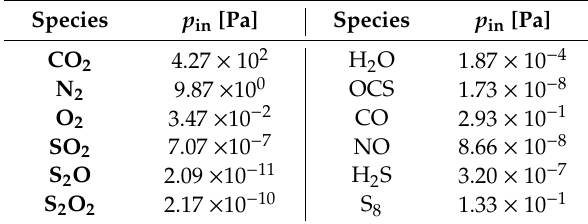
Table 3. Same as in Table 2 but for CO 2 , N 2 , and trace species. Combined CO 2 / N 2 contribution is 99.89%. Species p in